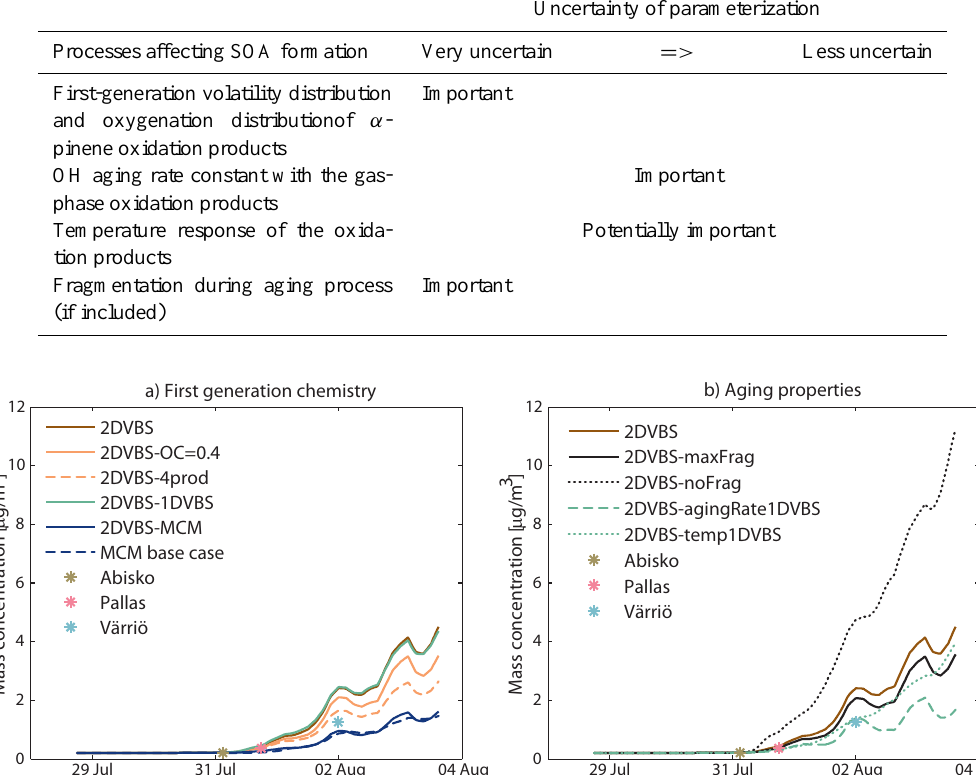
Figure 7. Particle growth along the air-mass trajectory modeled with different versions of 2DVBS (see Table 3 for more details). In (a) dif- ferent parameterizations of first-generation chemistry are tested and in (b) different parameterizations of gas-phase aging are tested.